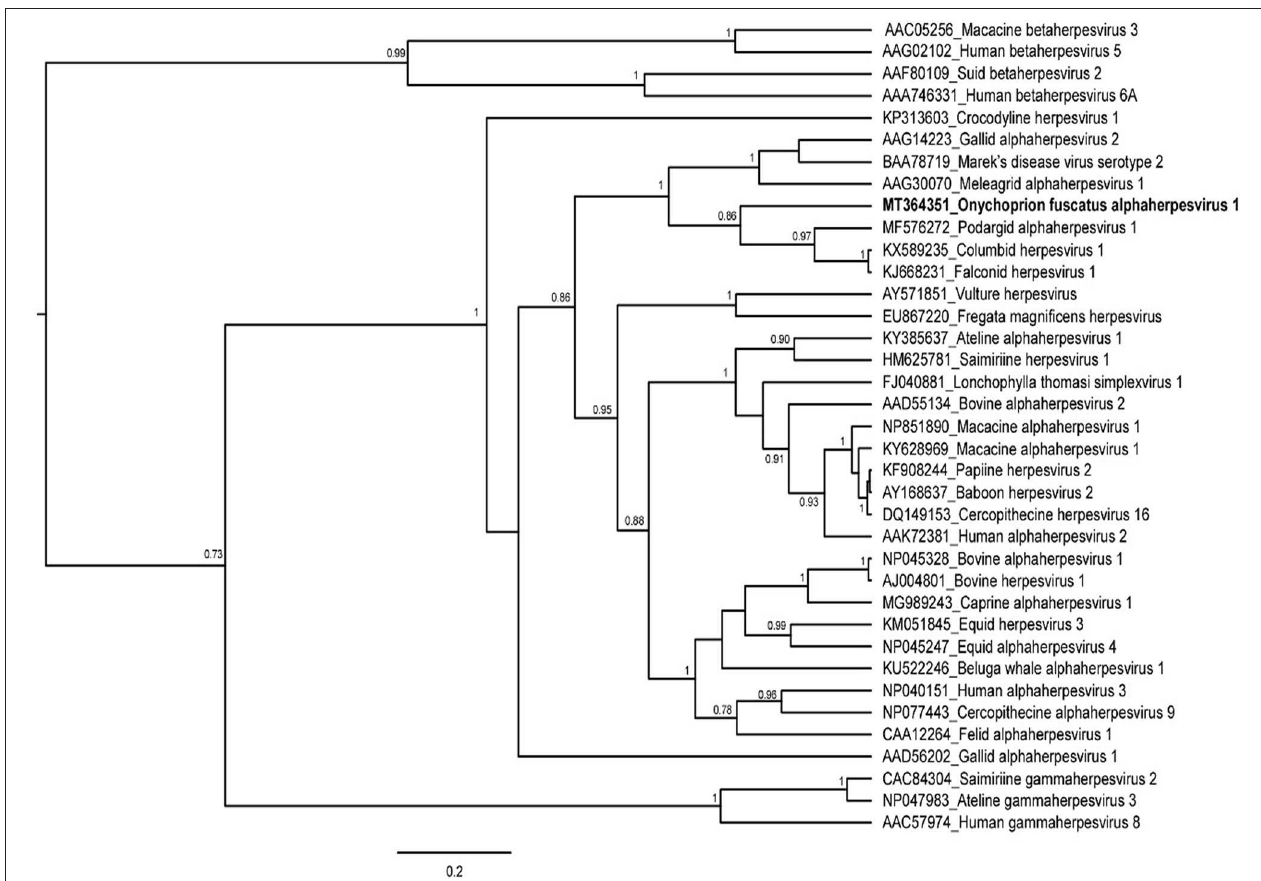
FIGURE 1 | Bayesian inference of the phylogenetic relationships of the herpesvirus sequence identified in the sooty tern Onychoprion fuscatus . Bayesian posterior probabilities are shown at the nodes, when above 0.70. The sequence of Onychoprion fuscatus alphaherpesvirus 1 is in boldface. Alphanumerical codes represent the Genbank accession numbers of each herpesvirus sequence used in this